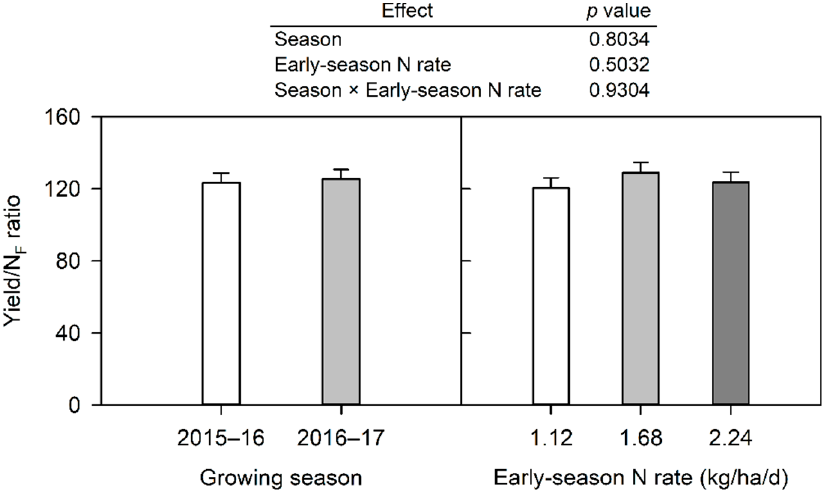
Figure 4. The ratio of marketable yield (yield, kg/ha) and total fertilizer nitrogen (N) input (N F , kg/ha) of ‘Florida Radiance’ strawberry as affected by season and early-season N fertilization rate. Fertilization treatments are as described in Table 1. Data are means ± SE. Data were pooled by each main effect, as they were not significantly affected by the season × early season N rate interaction ( p > 0.05).